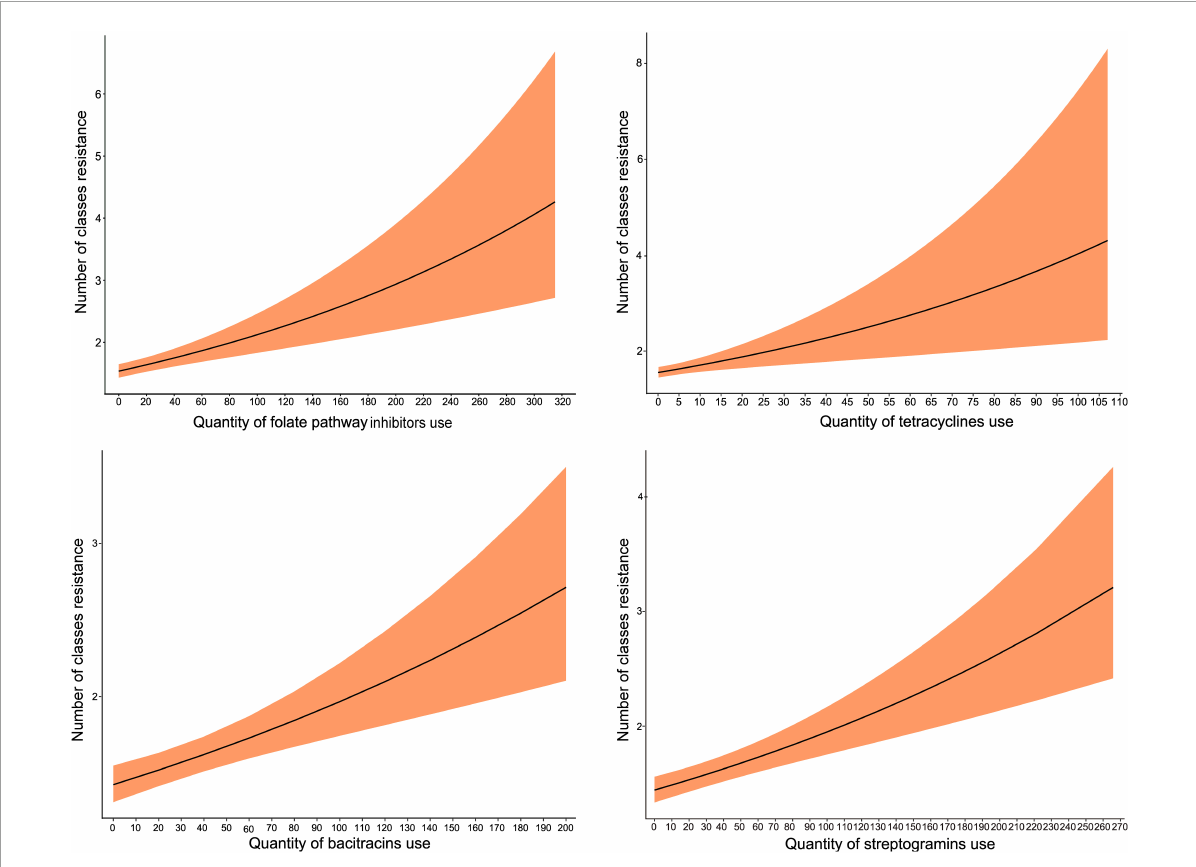
FIGURE2 Predicted marginal effects of antimicrobial use on the incidence of resistance to the number of antimicrobial classes in E. coli isolates (nCR E . coli ) of turkeys. The antimicrobial used was represented by the number of defined daily doses per 1,000 kg-animal days at